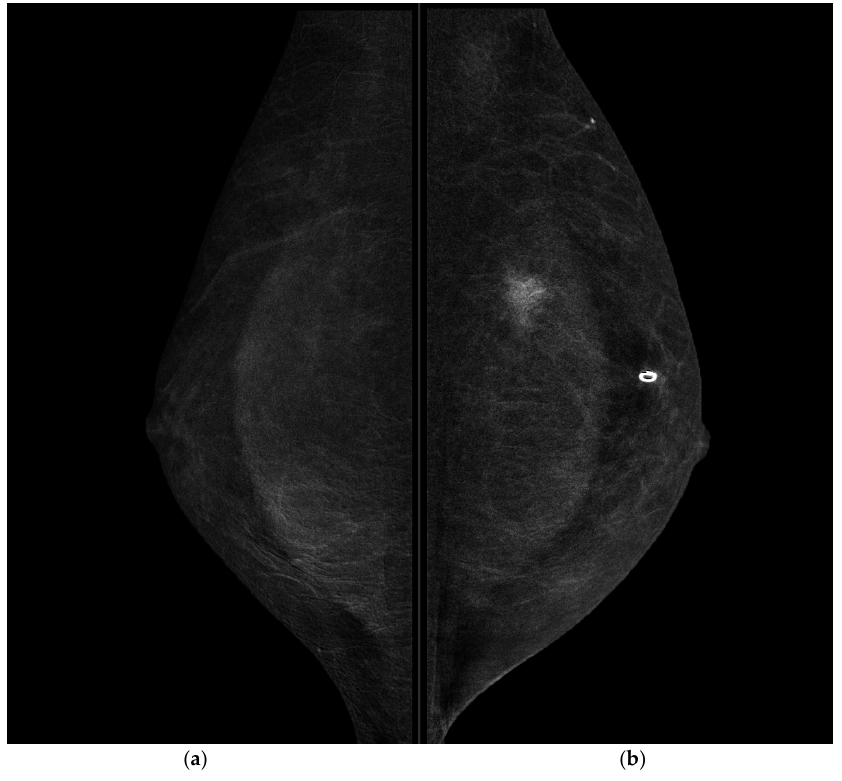
Figure 4. CESM MLO projections of the right breast ( a ) and left breast ( b ). A highly suspicious enhancement area with indistinct margins of 15 mm in the superior pre-pectoral region of the left breast was confirmed in MLO projection. Some microcalcifications were seen in the anterior margin of the lesion both in ax- ial and medio-lateral oblique projections, allowing a mammographically guided biopsy approach (Figures 5 and 6).